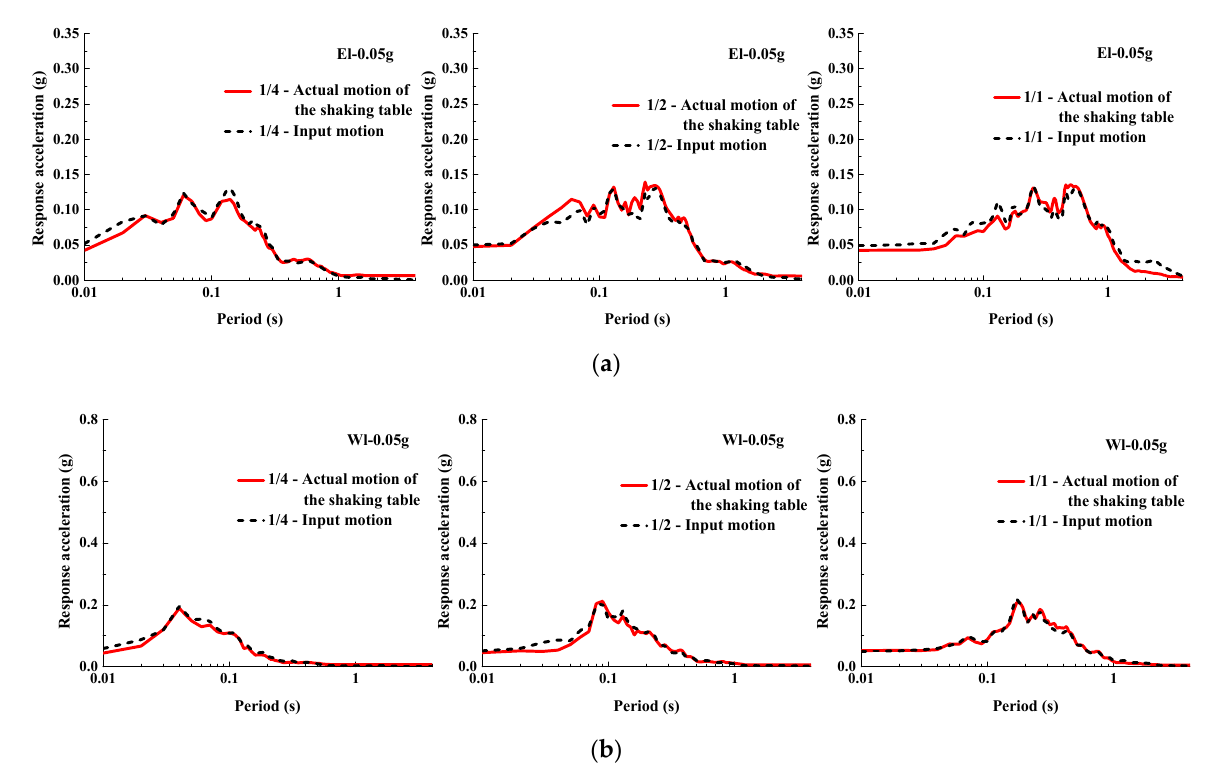
Figure 9. Acceleration response spectra: ( a ) El Centro record; ( b ) Wolong record.